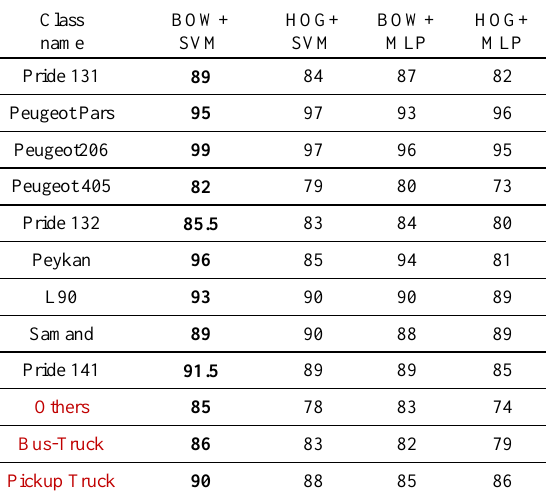
Table 4. Comparison of methods